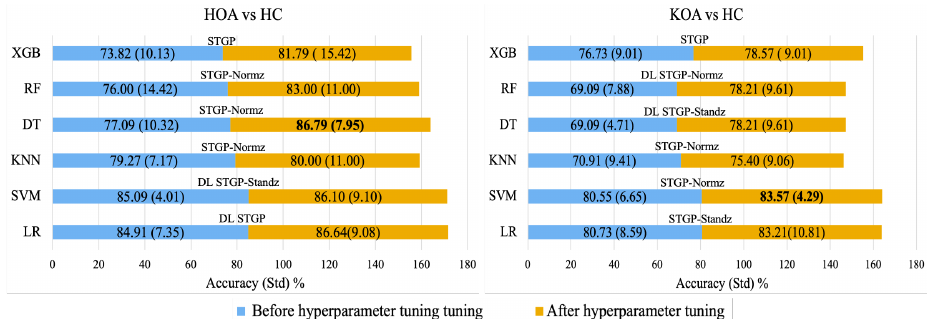
Figure 16. Best accuracy for each baseline ML model with its input data before hyperparameter tuning ( blue color ) and after hyperparameter tuning ( gold color